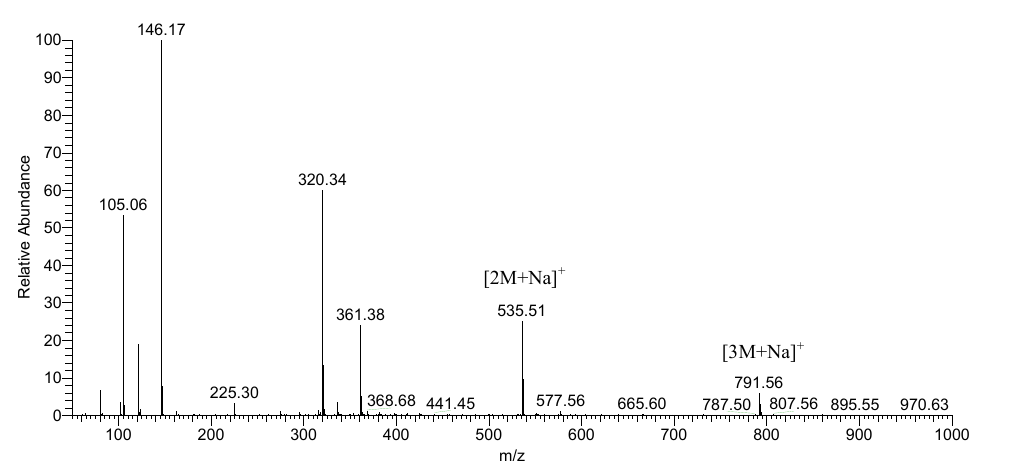
Figure 2. ESI-MS mass spectrum of UV-exposed PI 10. The dimer and trimer adduct of 10 are seen as sodiated adducts ([2M + Na] + and [3M + Na] + ) at m / z 535.51 and 791.56, respectively.